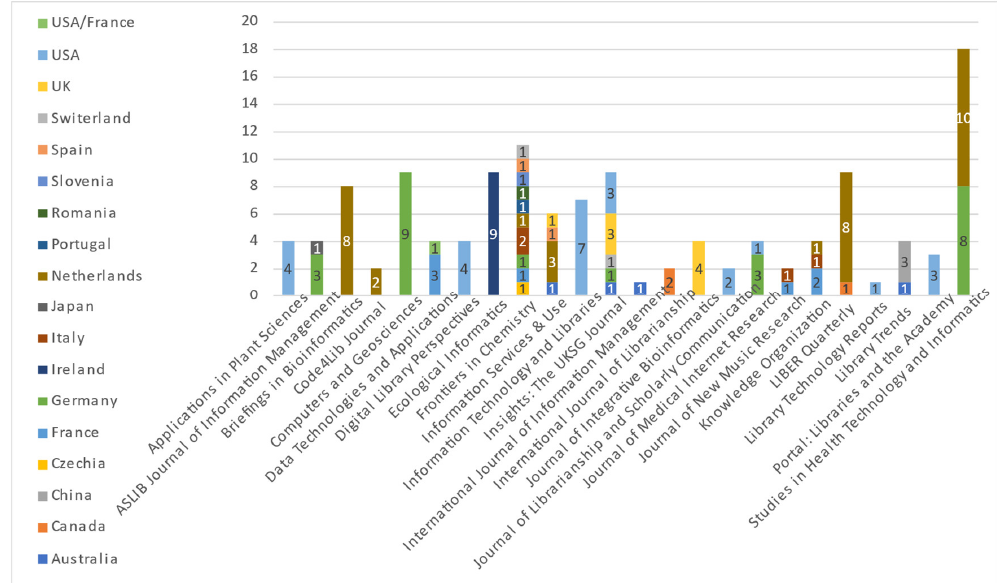
Figure 9. Geographical Distribution of Authors by Journal.